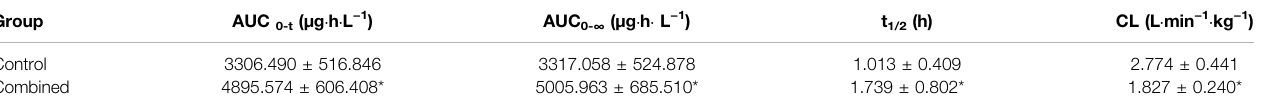
TABLE 2 | Pharmacokinetic parameters of PG alone and in combination with GAO ( n = 8).